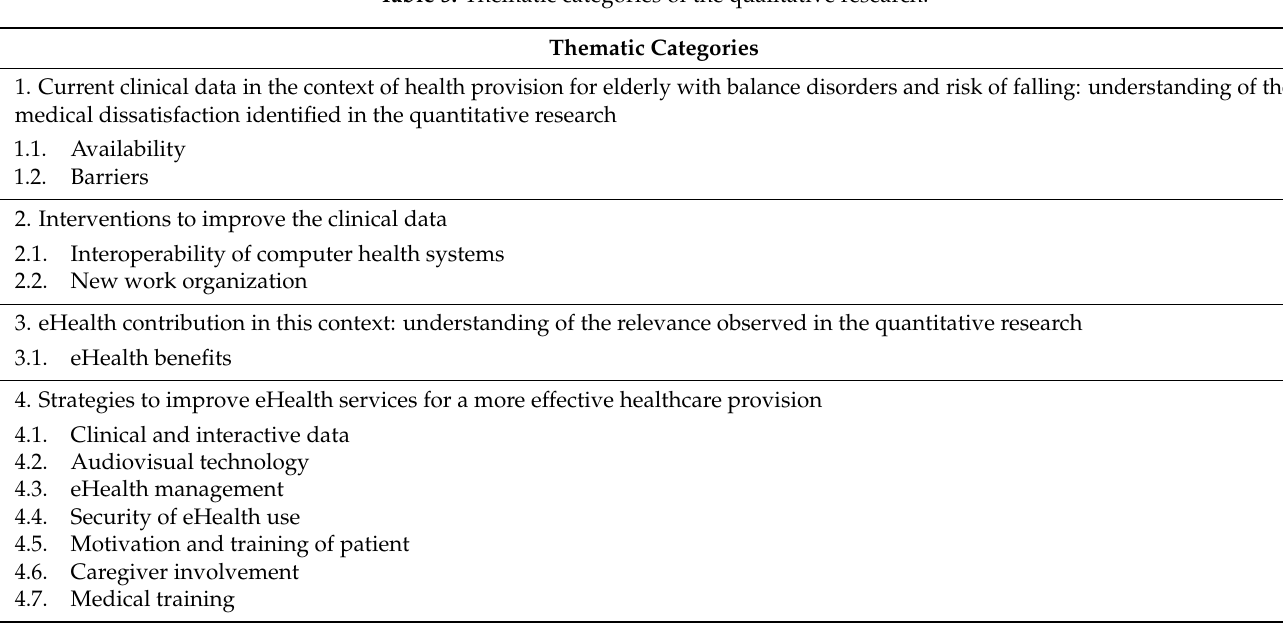
Table 5. Thematic categories of the qualitative